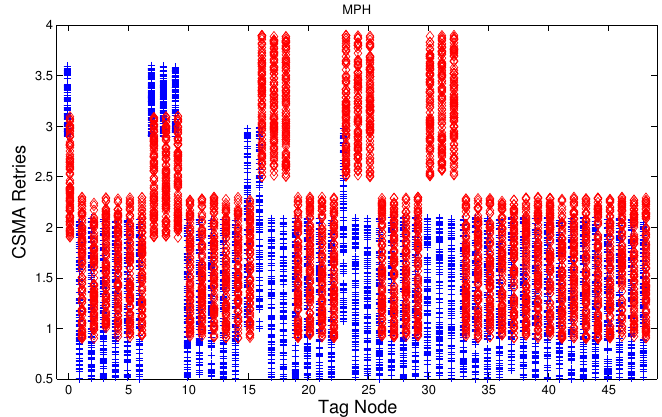
Figure 9. Average number of retries (MAC algorithm) for the nodes from Figure 3 for MPH (Multi-Parent Hierarchical) under normal (blue) and jamming (red) conditions.